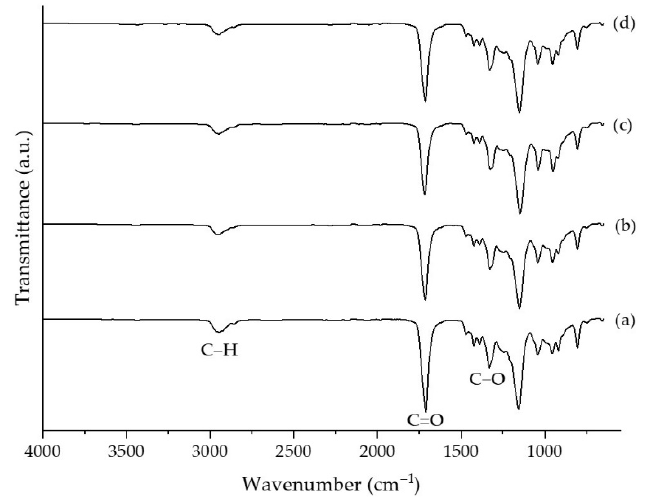
Figure 4. FTIR spectra of ( a ) untreated PBS, ( b ) O 2 -plasma-treated for 30 s, ( c ) Ar/O 2 -plasma-treated for 30 s, and ( d ) O 2 plasma 60 s more Ar plasma 240 s.